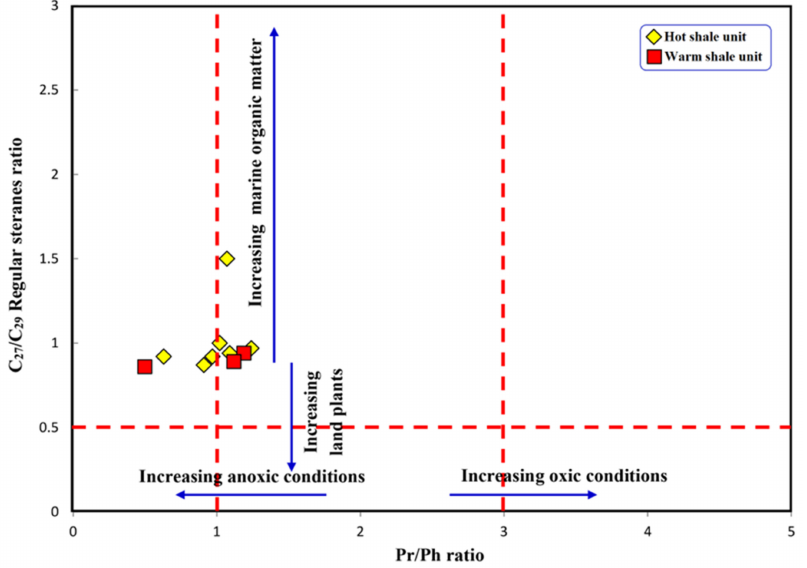
Figure 13. Geochemical biomarker result of the analyzed shales of the Qusaiba units shows pristane/phytane/ n -C18 versus C27/C29 regular sterane ratio, further indicating that these sediments contain a mixture of organic matter and were deposited under suboxic to anoxic environmental